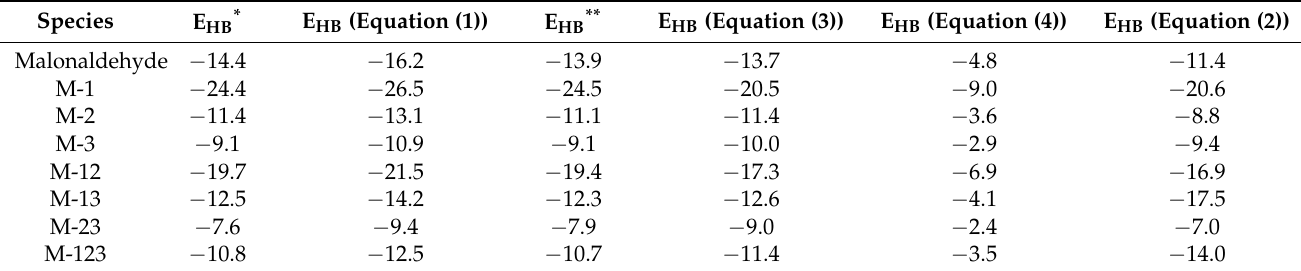
Table 7. The energies (in kcal/mol) of intramolecular hydrogen bonds estimated from various approaches; E HB* is the energy calculated from the linear relationship between ρ BCP (Table S3) and E int BSSE (Table 5), for complexes linked by intermolecular O–H ··· O hydrogen bonds (Equation (9)). E HB** is the interaction energy calculated from one of relationships of Espinosa [37], E HB** = 6111.11exp( − 3.6 r); r is the H ··· O distance in O–H ··· O hydrogen